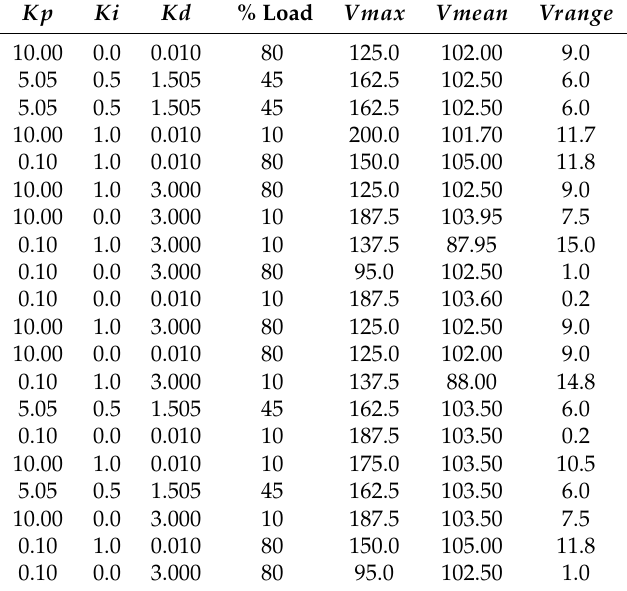
Table 2. Fractional factorial design with the factors Kp , Kd , Ki and the percentage of connected load (%). The responses considered were the maximum voltage ( Vmax ), the average set point ( Vmean ), and the voltage range ( Vrange